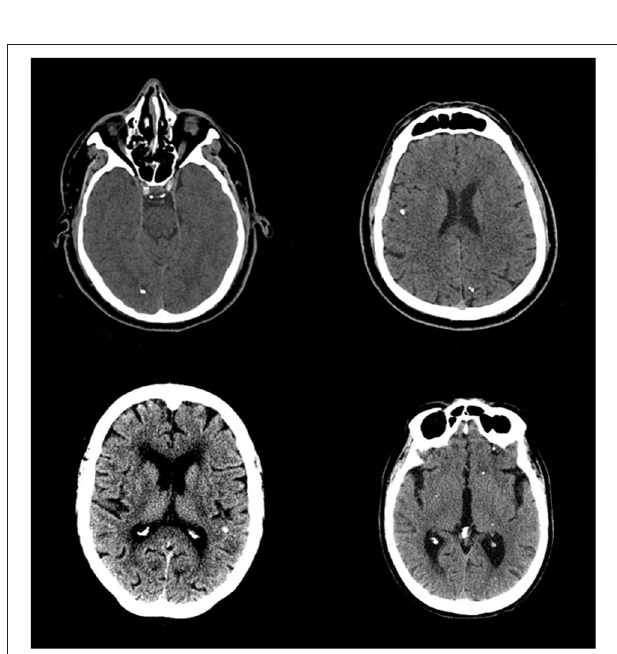
FIGURE 2 | CT-scans of four different patients showing small calcifications (1–10mm in diameter), single or multiple, located in brain parenchyma. These lesions are typically observed in patients with calcified neurocysticercosis and can be easily observed using